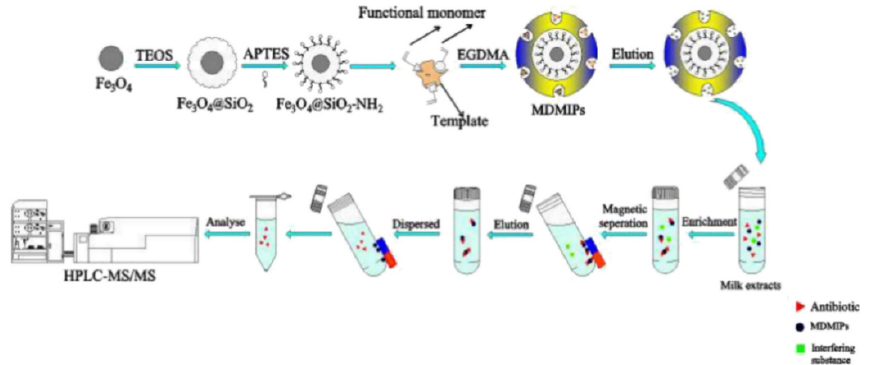
Figure 10. The schematic representation of the proposed MSPE process based on MDMIPs for AGs